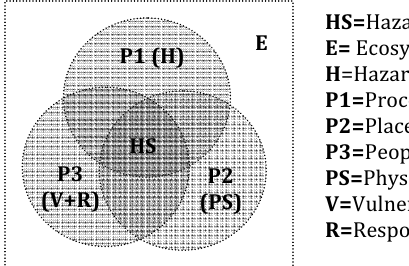
Fig 2 A venn diagram of a hazardscape Fig. 2. A venn diagram of a